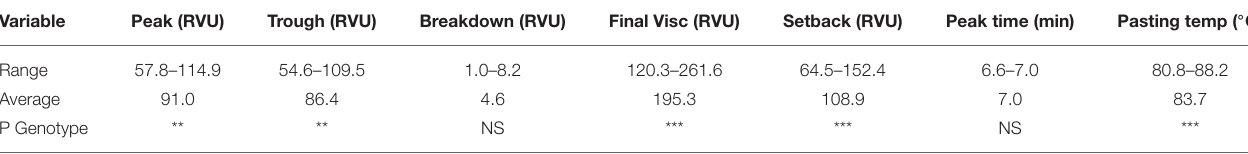
TABLE 4 | Pasting properties of Striga -resistant yellow-orange maize hybrids grown at Zaria and Saminaka ( N = 64). Variable